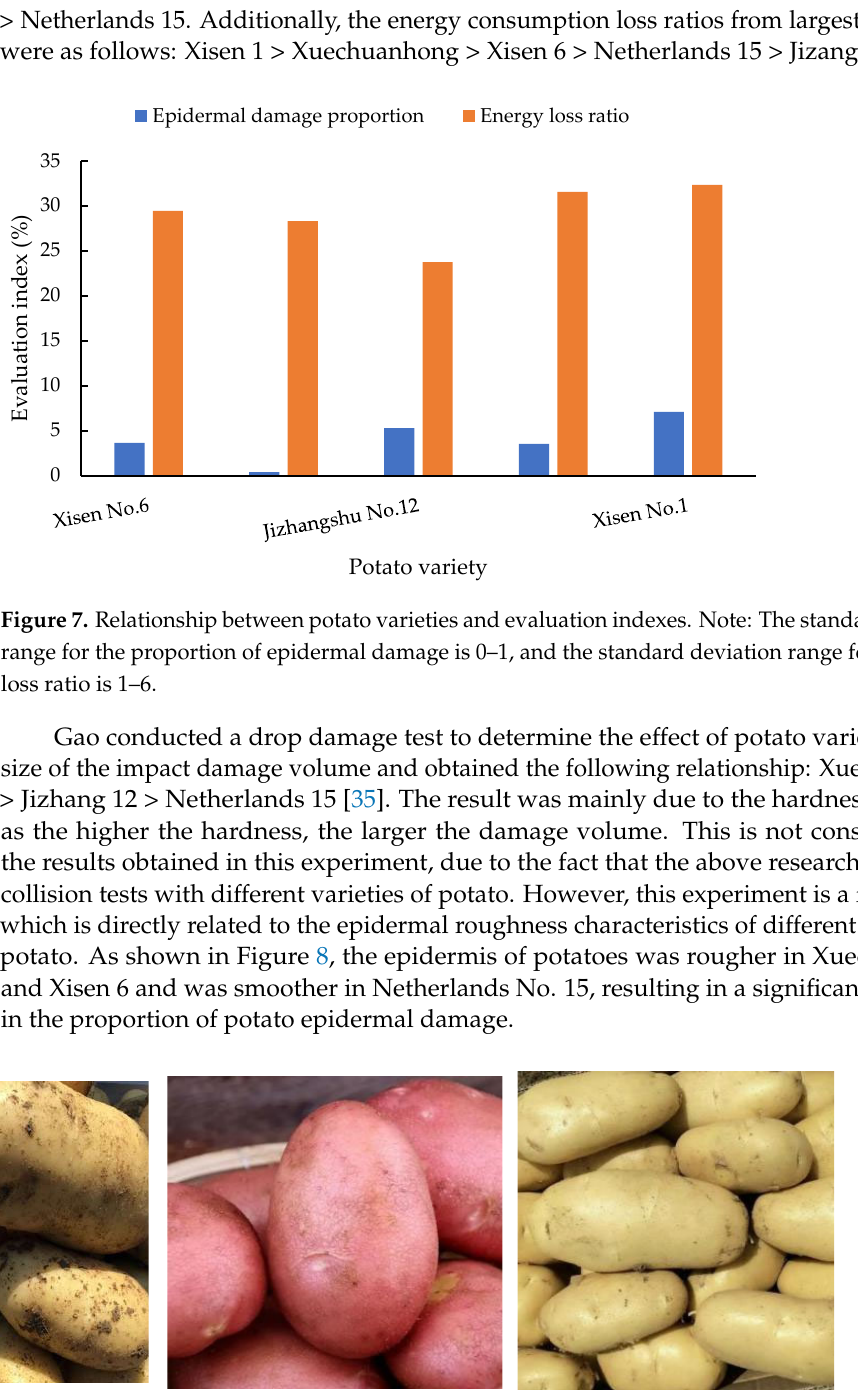
Figure 8. Appearance of different varieties of potatoes.